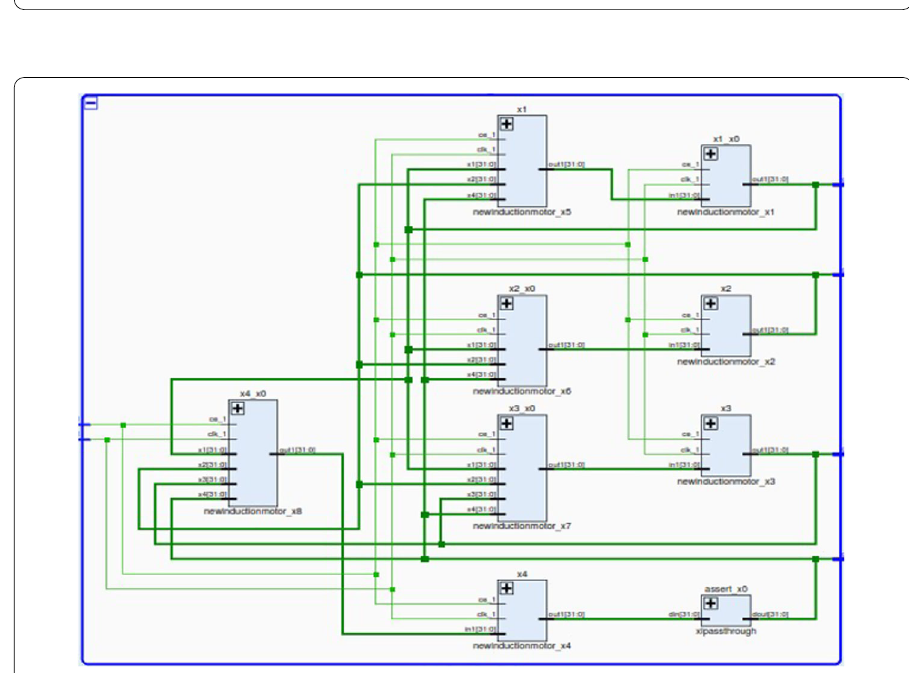
Figure 14 Xilinx RTL schematics of the FOIM system.